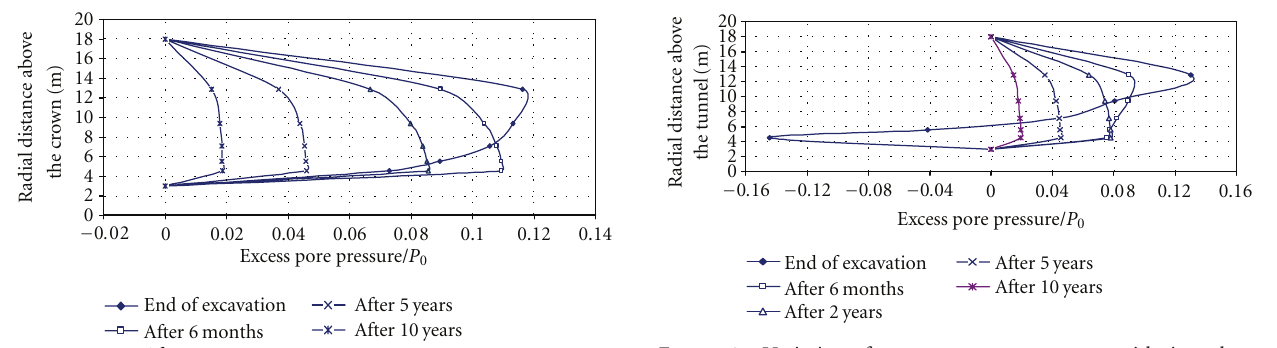
Figure 27: Variation of excess pore water pressure with time along section D-D above the crown using reduced k 0 .